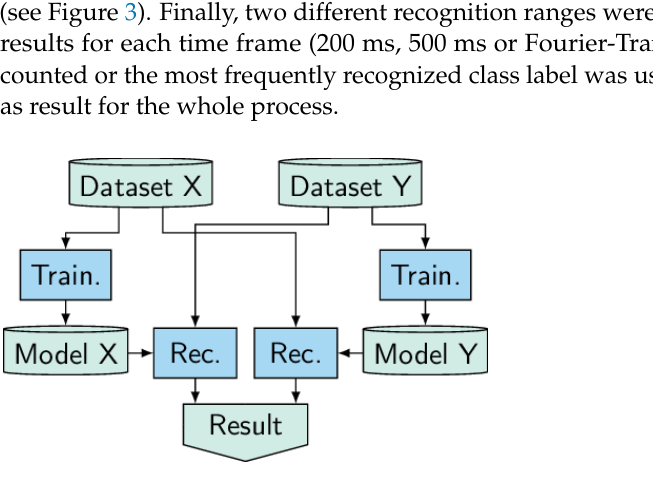
Figure 3. Two-fold cross validation on dataset X and Y with training (Train.) and recognition (Rec.). As neural networks are initialized with random numbers, results may be misinter- preted if very good or bad values are used for initialization. Therefore, the whole training